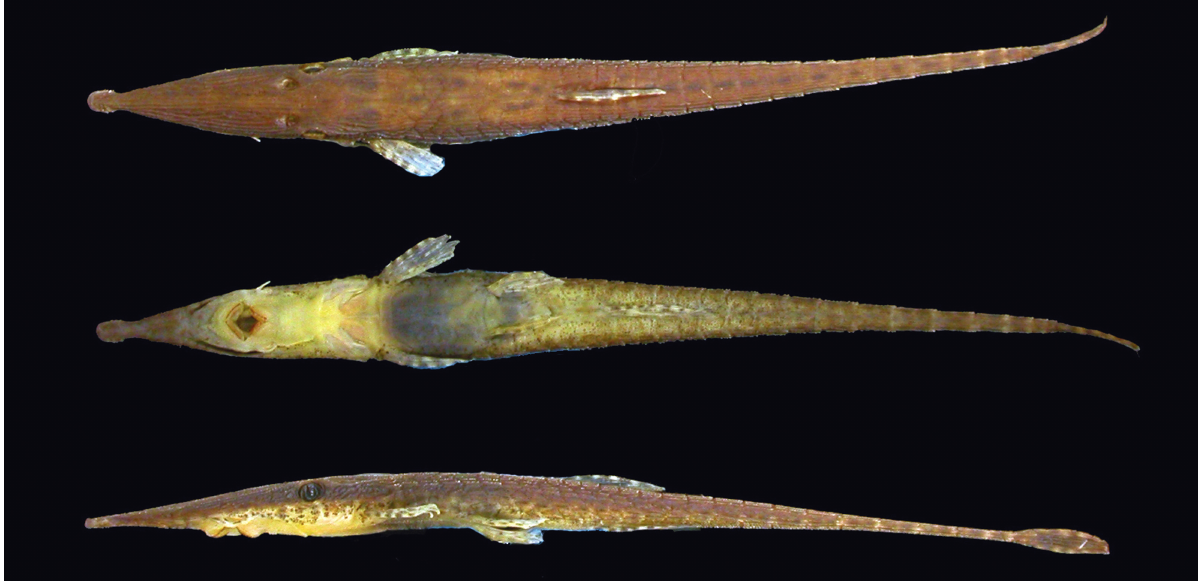
Fig. 1. Acestridium triplax , MPEG 13355, holotype, 55.5 mm SL, female, Igarapé Mutum, Jurutí, Amazonas river Basin, Pará,